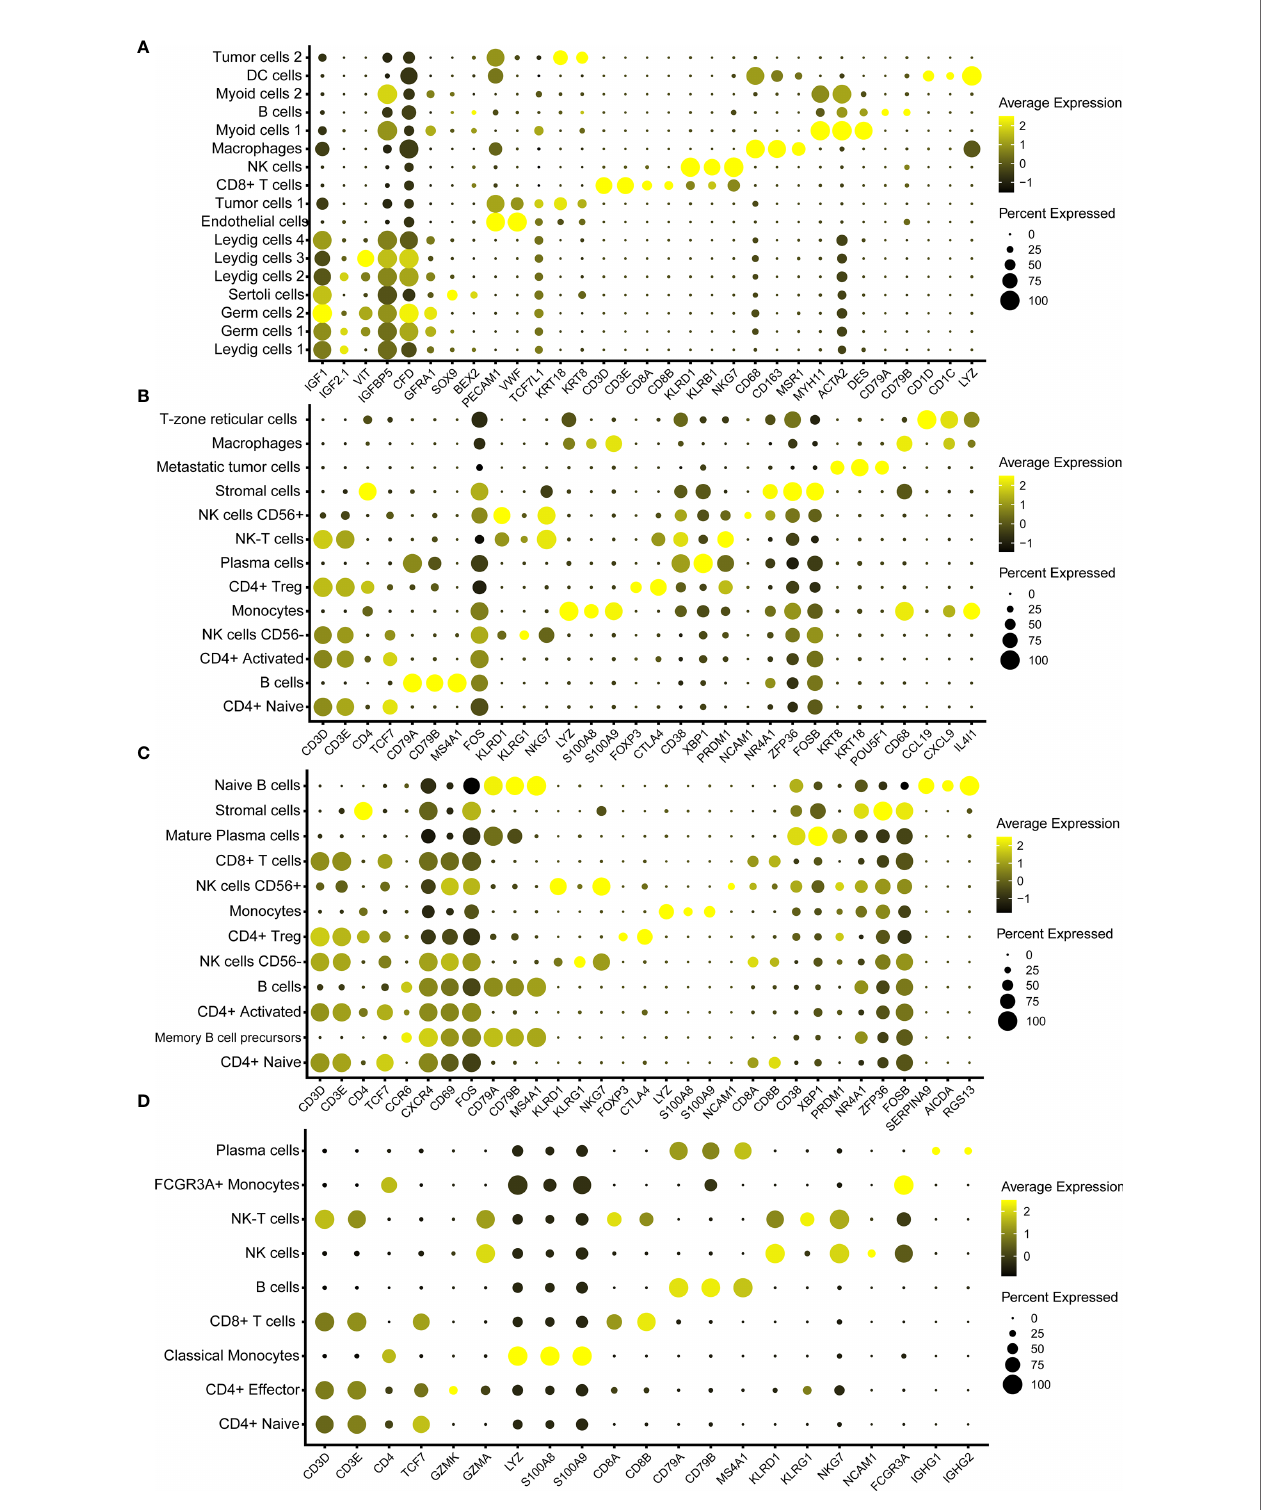
FIGURE 3 | Bubble chart showing the marker genes of each cluster in testicular tumor (A) , left pelvic lymph node (B) , left renal hilus lymph node (C) and PBMCs (D)